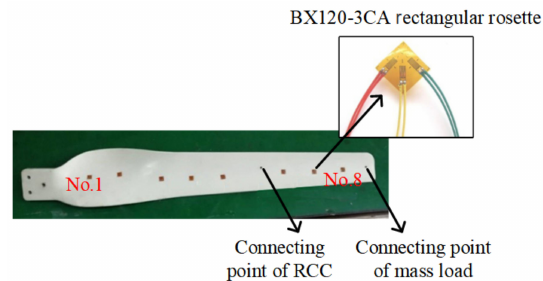
Figure 14. Diagram of strain measuring point on the blade.